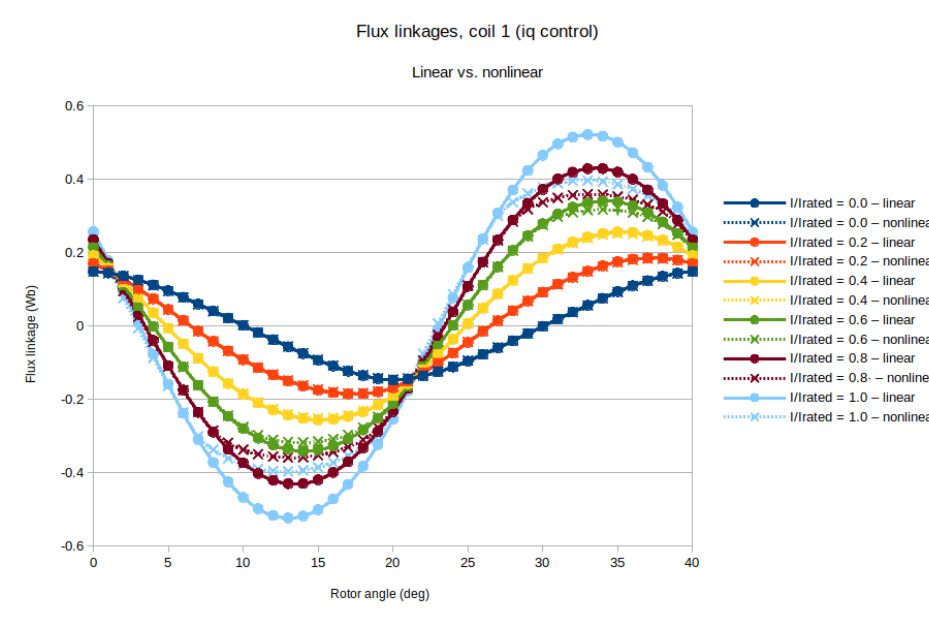
Figure 13. Flux linkages under i q control.